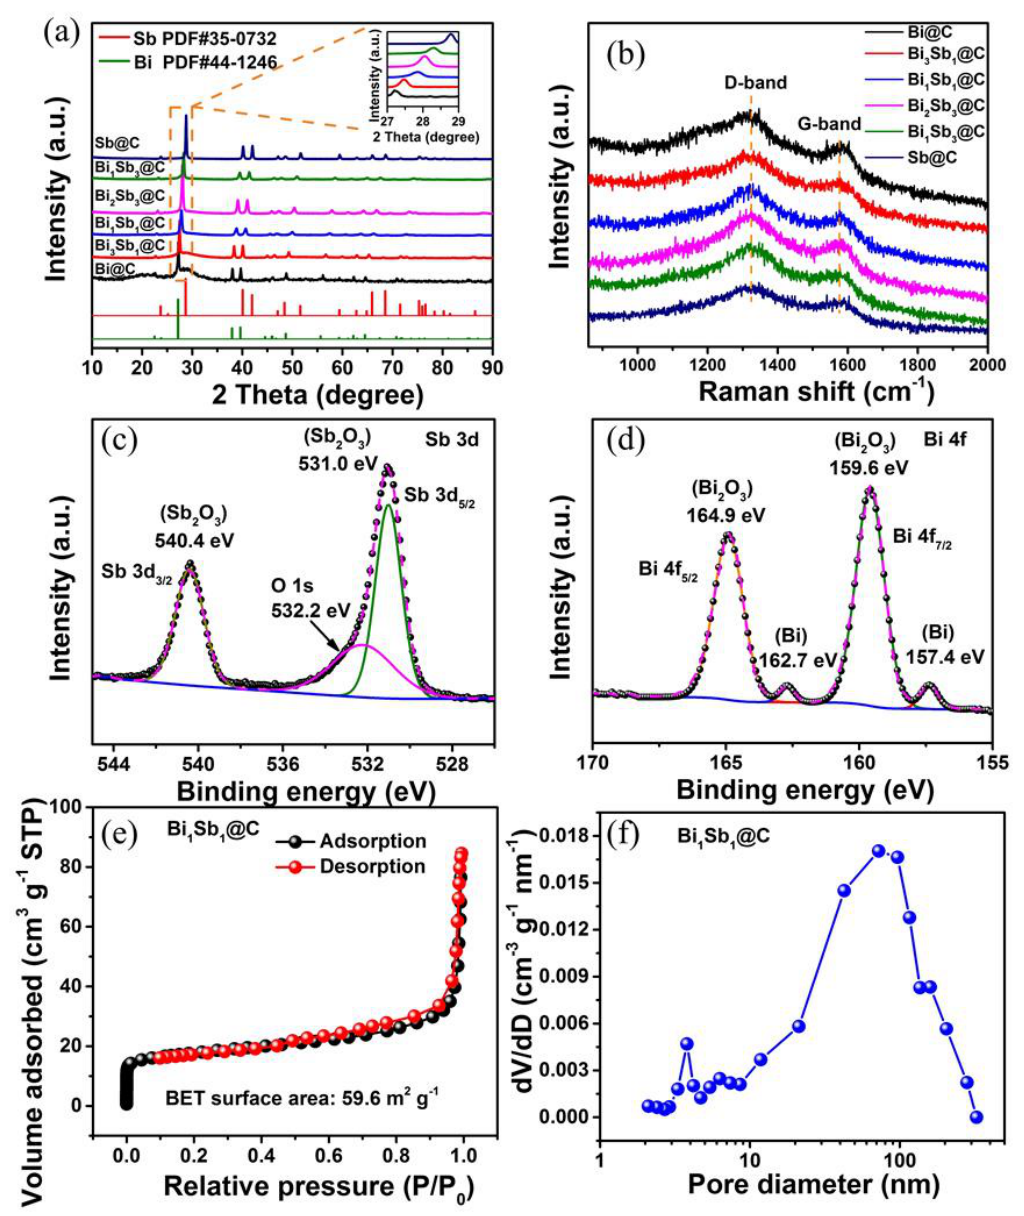
Figure 2. ( a ) XRD patterns in the range of 10° – 90° and ( b ) Raman results of the Bi−Sb@C samples, respectively. High-resolution XPS spectra of ( c ) Sb 3d and ( d ) Bi 4f for the Bi 1 Sb 1 @C sample. ( e ) N 2 adsorption/desorption isotherms and ( f ) pore size distribution curves of the Bi 1 Sb 1 @C sample.